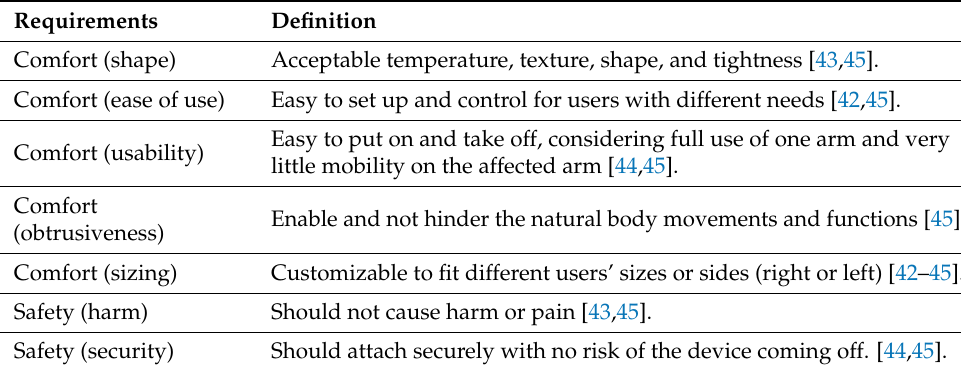
Table 1. Design requirements for the wearability of